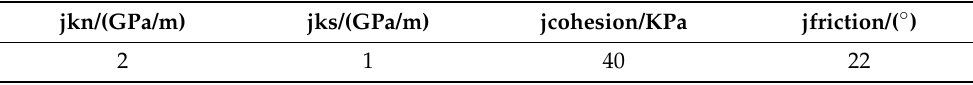
Table 3. Strength parameters of